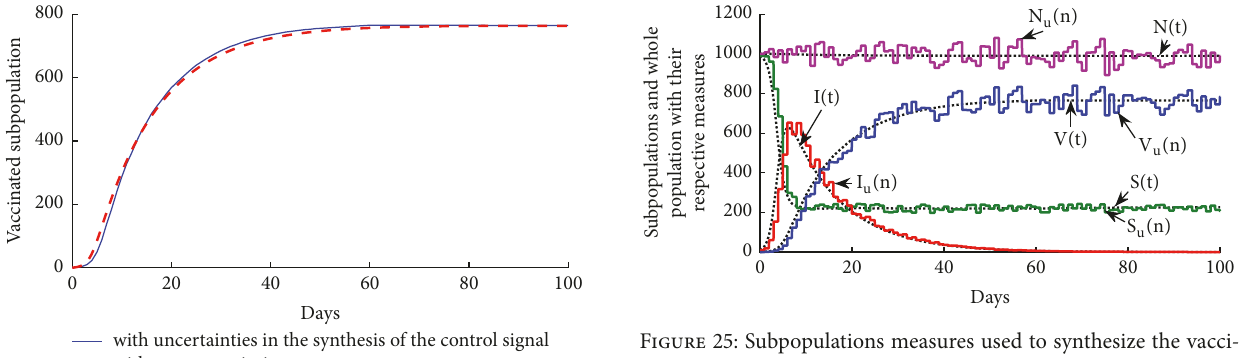
Figure 25: Subpopulations measures used to synthesize the vacci- nation control signal in comparison with the real time evolution of such subpopulations and whole